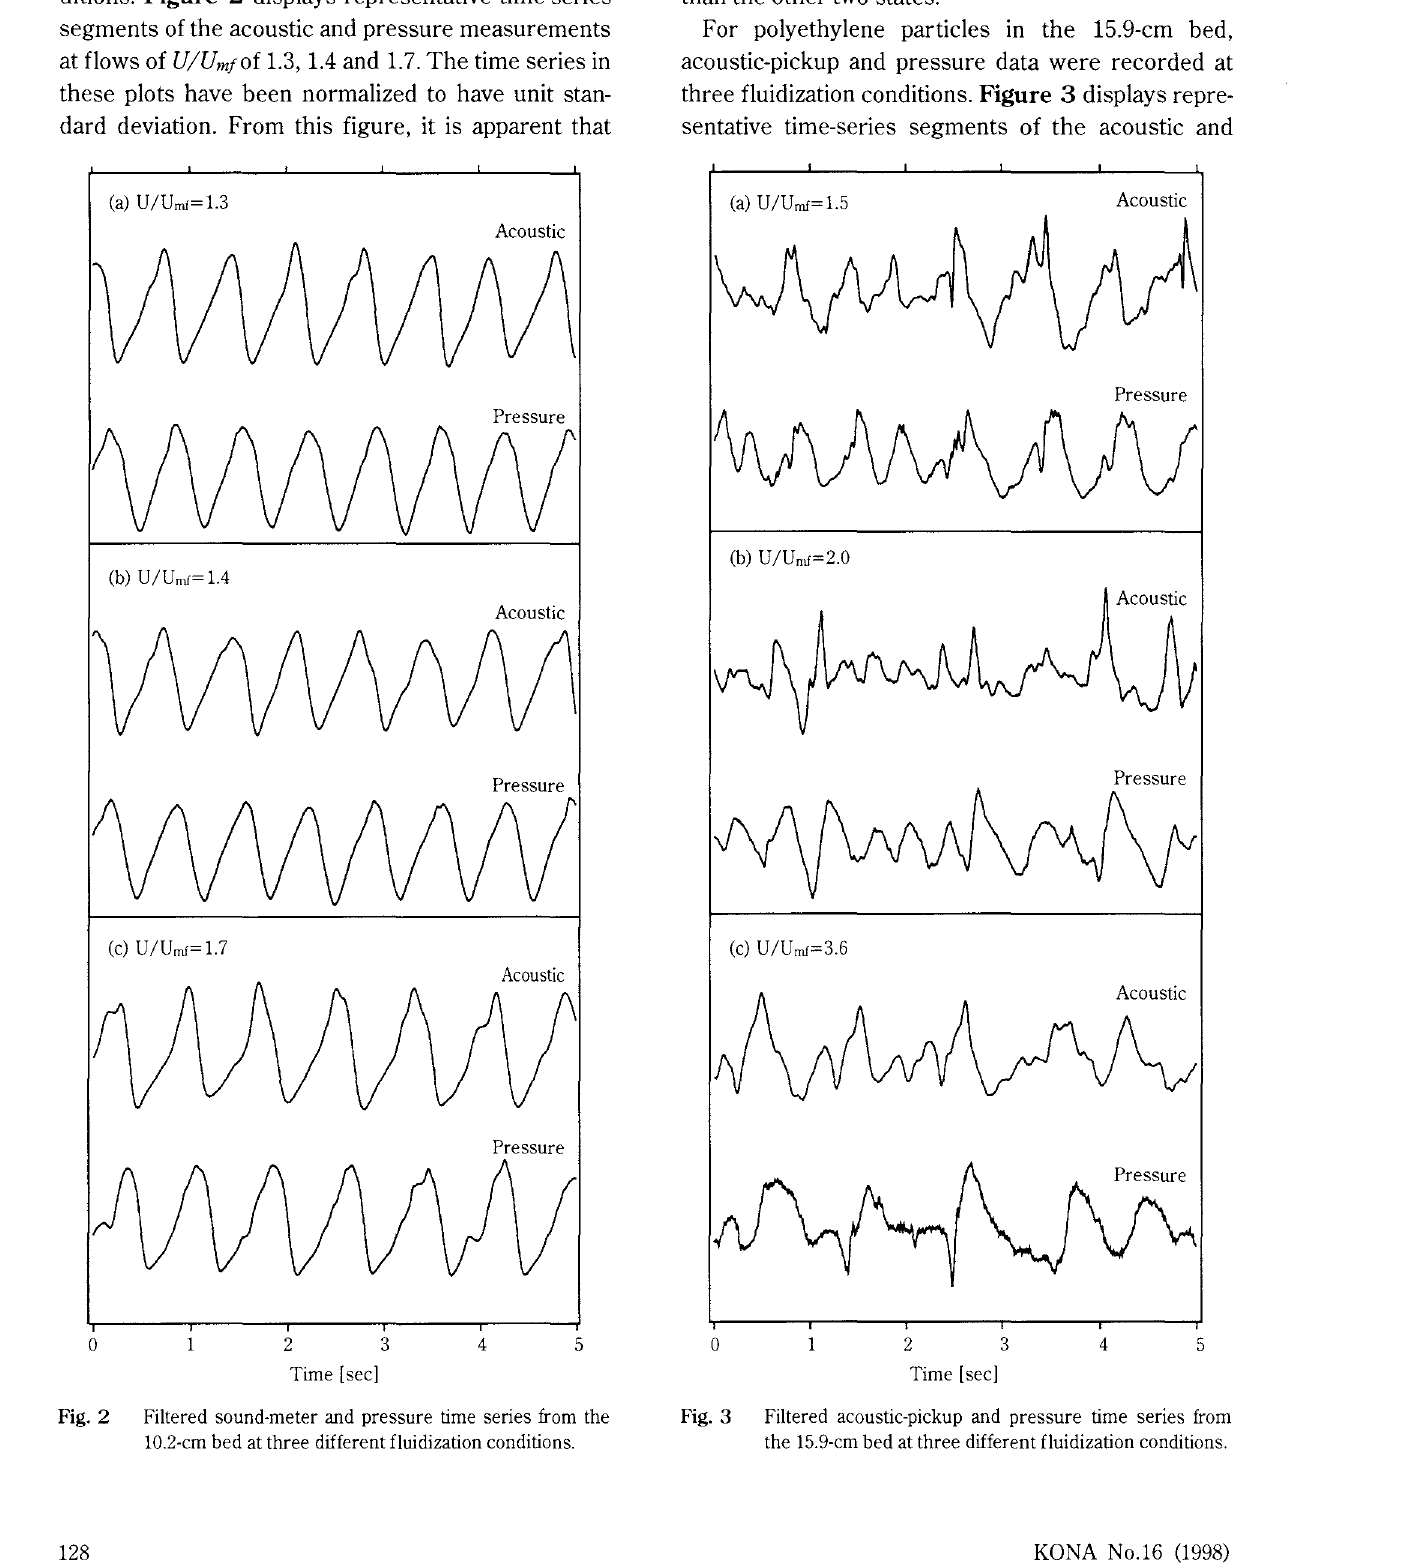
Fig. 3 Filtered acoustic-pickup and pressure time series from the 15.9-cm bed at three different fluidization